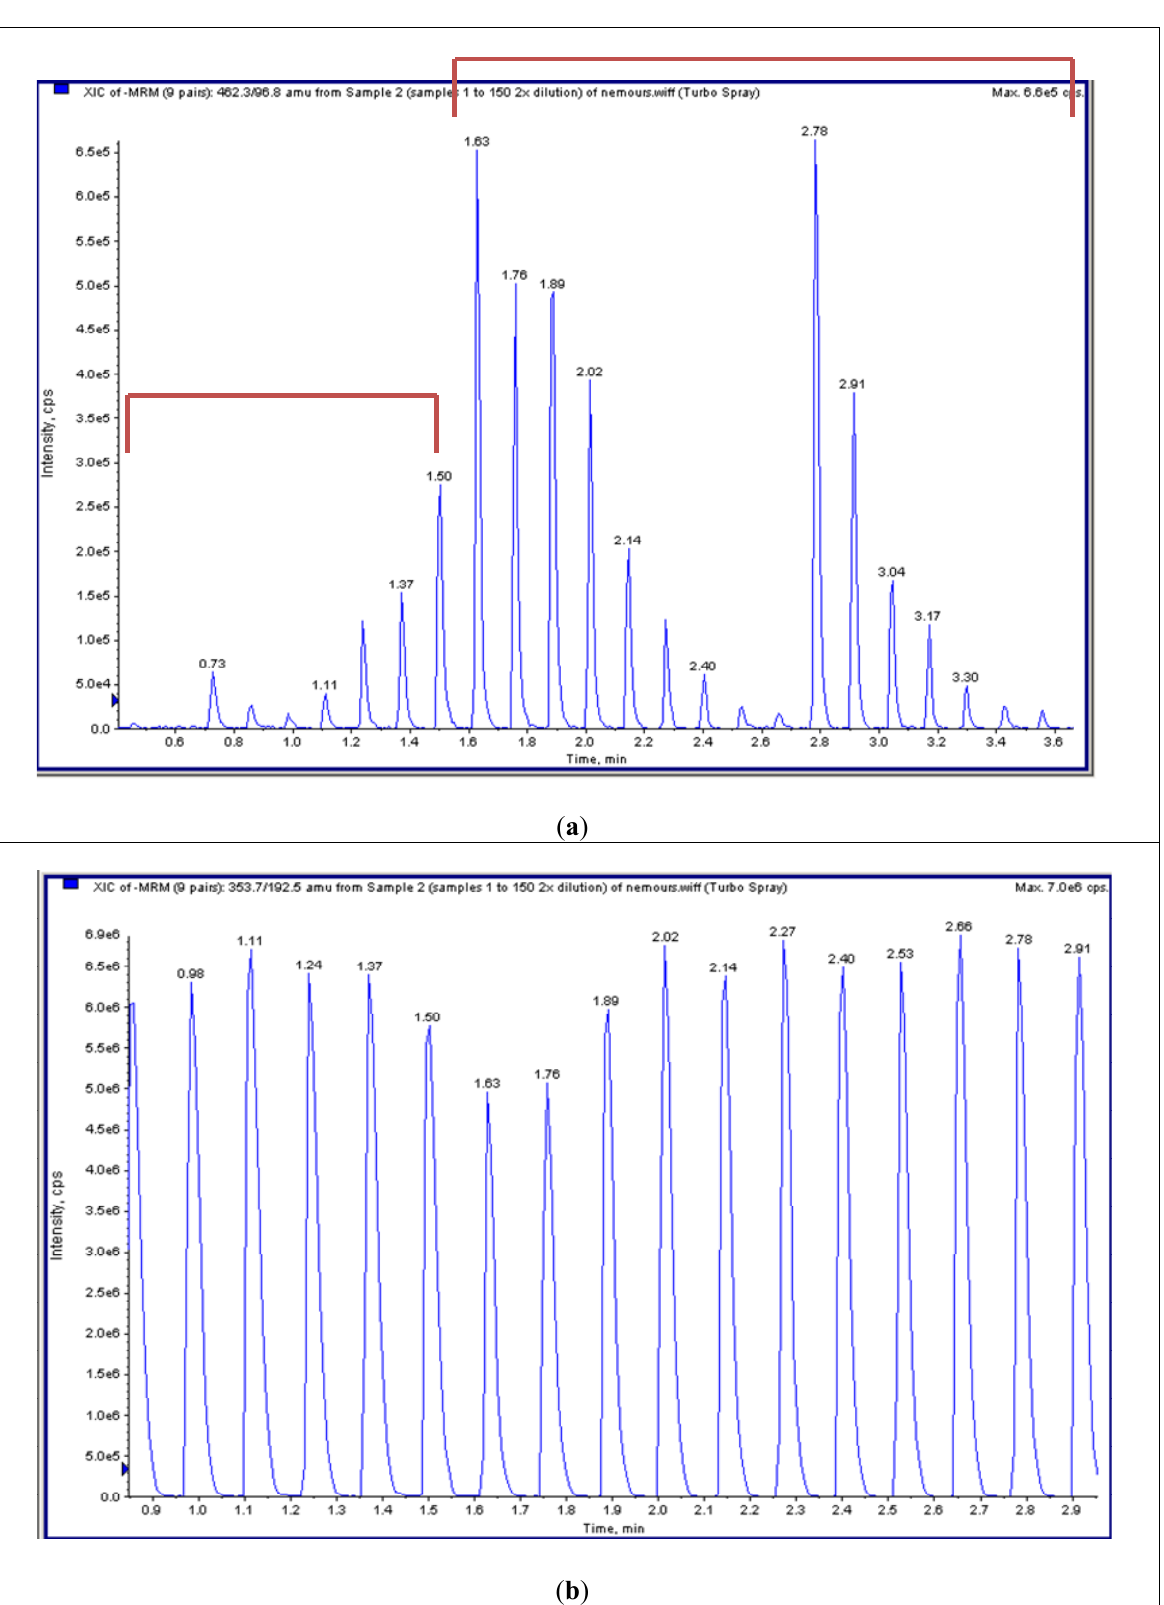
Figure 3. Multiple reaction monitoring (MRM) of HT-MS/MS. ( a ) Multiple injections of mono-sulfated KS with a series of dilutions in duplicate shows seven gradient peaks per a set of dilutions (as well as other surrounding samples). ( b ) Multiple injections of chondosine (Q1; 353.7, Q3; 192.5) with the same concentration shows 8 peaks per